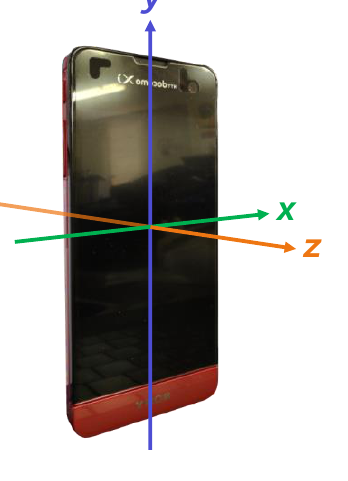
Figure 3. Coordinate system